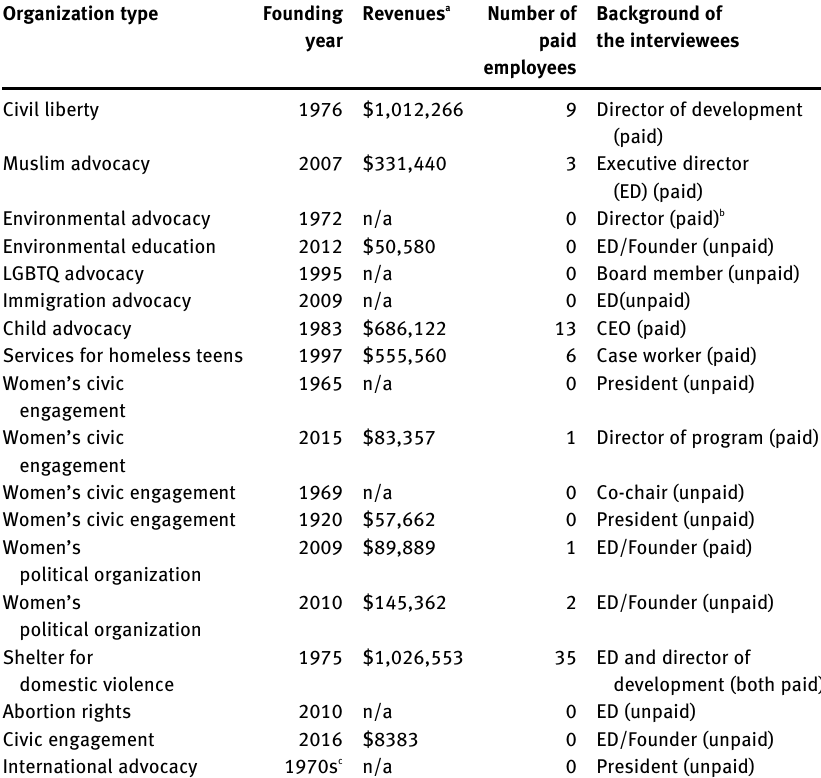
Table  : Descriptions of the organizations